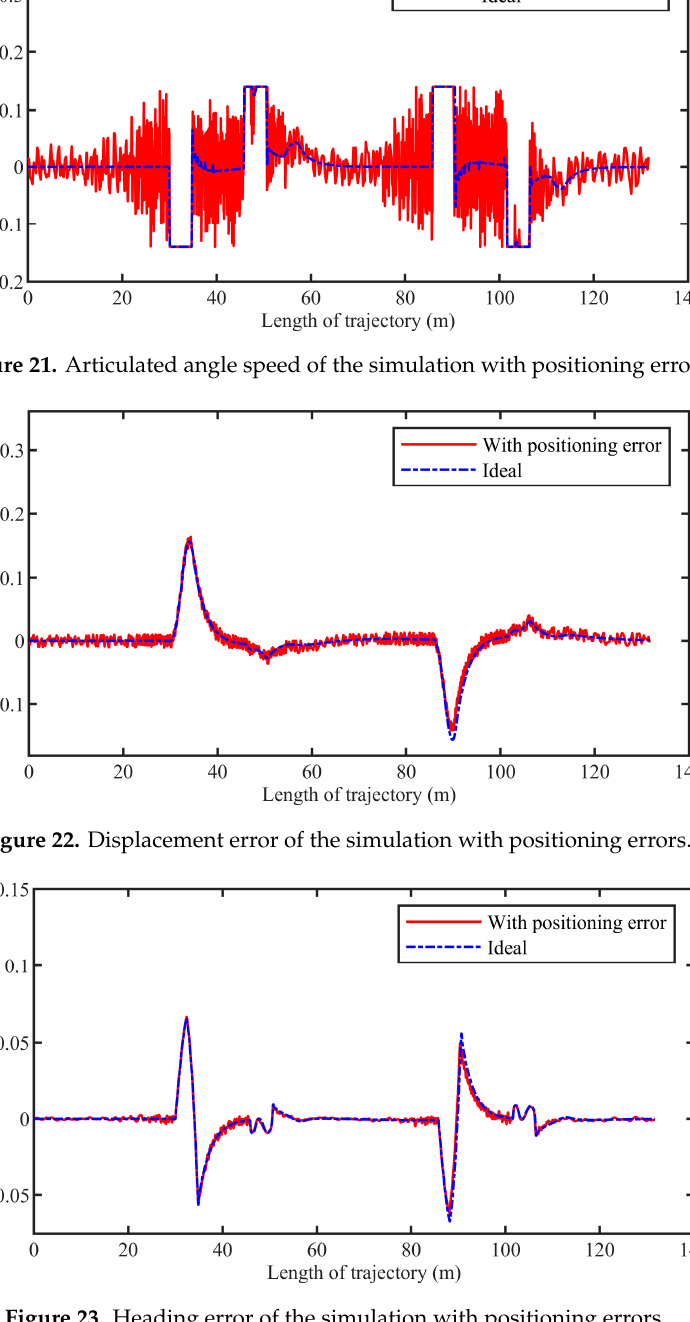
Figure 23. Heading error of the simulation with positioning errors.